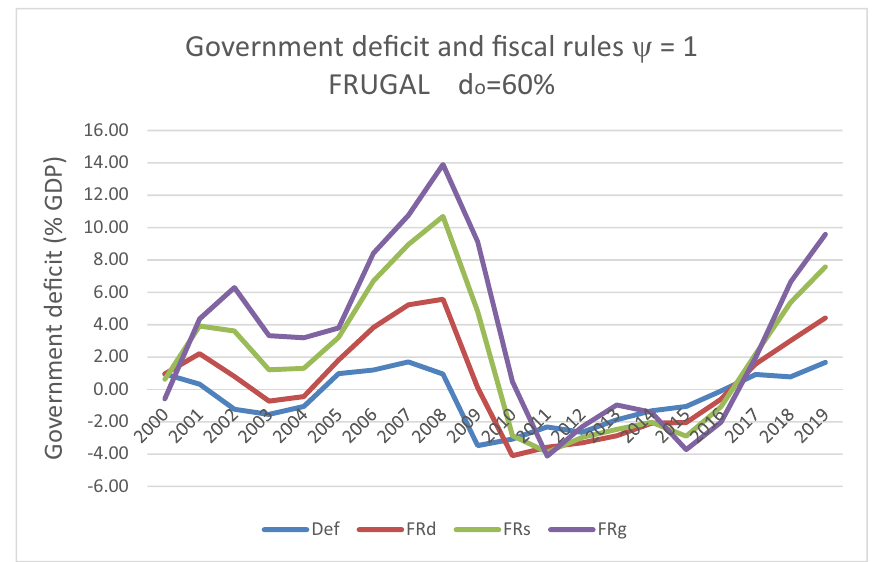
Figure 1.8: Frugal countries government de fi cit ψ = 1 ( Source: Own elaboration from data on Table 1 )